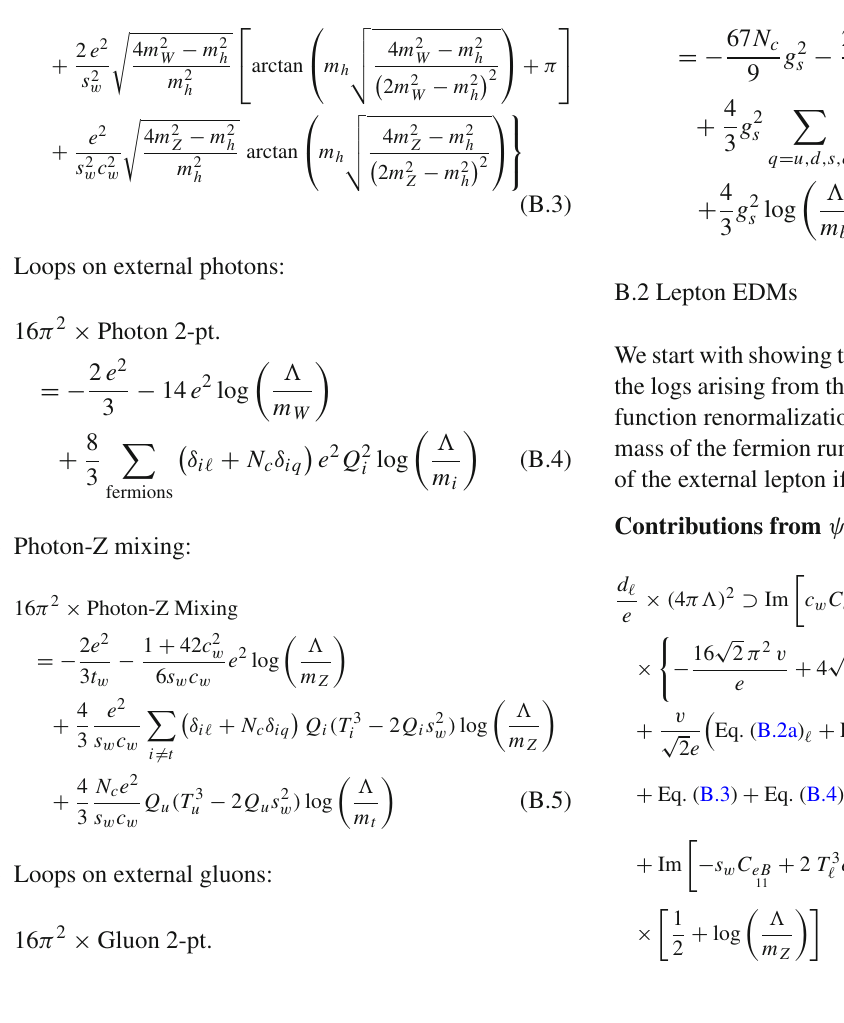
diagrams show the contribution of the down-type dipole operators. The corresponding up-dipole diagrams can be obtained by just exchanging up and down quarks